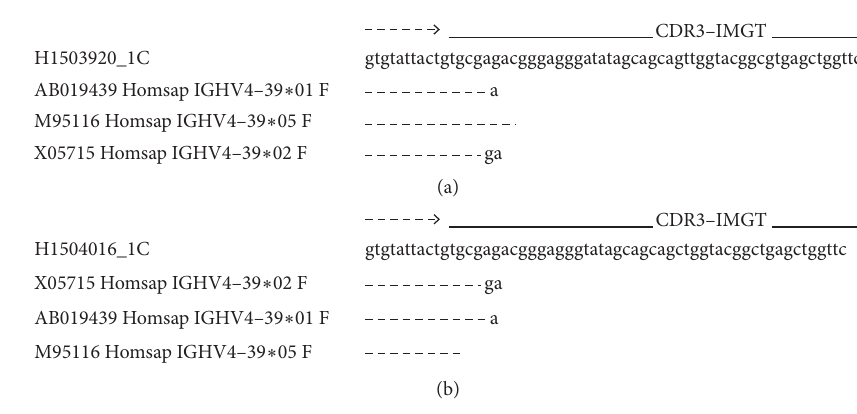
Figure 3: Sequences of the CDR3 region in the IGHV of the bladder tumor (a) and nasal tumor (b).The sequence of the CDR3 region in both tumors